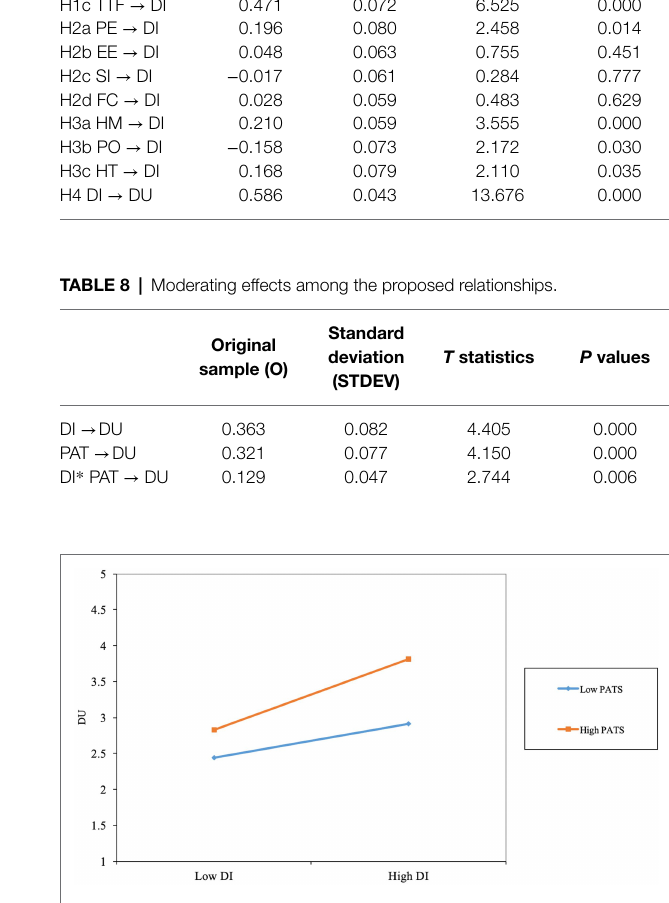
FIGURE 4 | The slope test